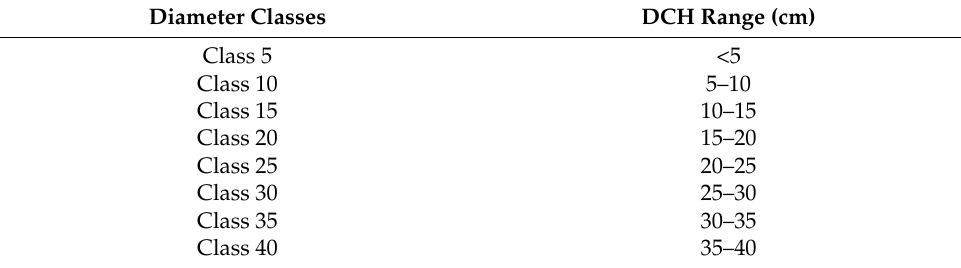
Table 2. Diameter classes existing in Parcels 1 and